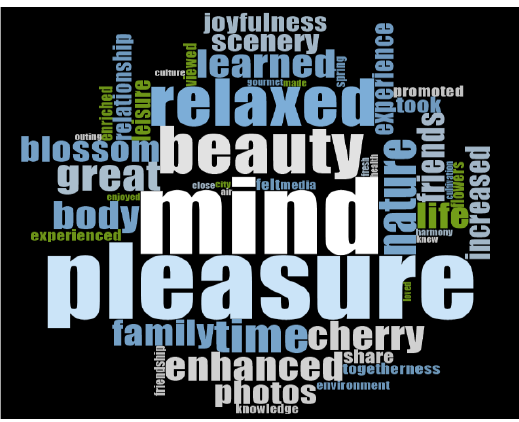
Figure 6. Stated benefits by tourists. Table 2. Frequency of words for locals and